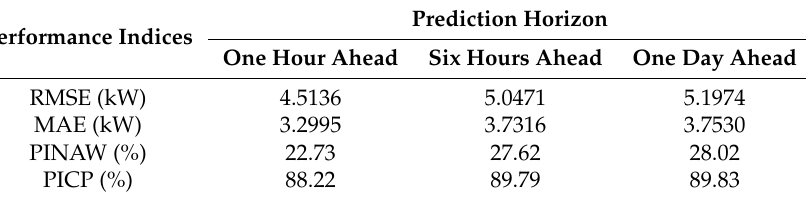
Table 2. Performance indices of fuzzy prediction interval model. MAE: mean absolute error; PICP: prediction interval coverage probability; PINAW: prediction interval normalized average width; RMSE: root mean square error.